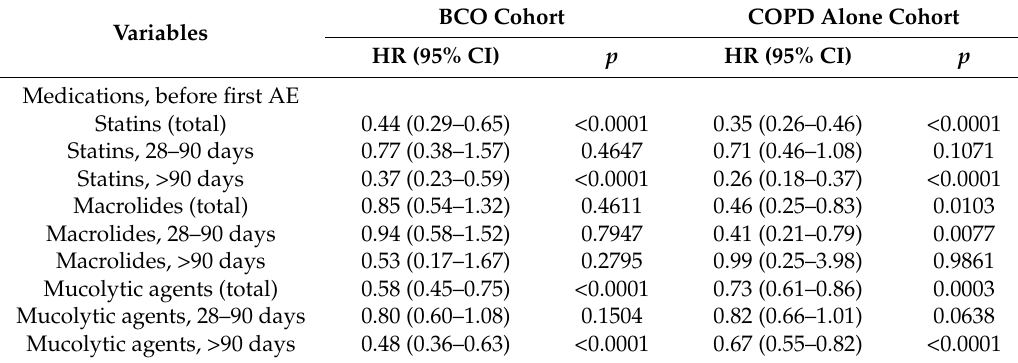
Table 3. Sensitivity analysis for the effects of medications on acute exacerbations in the bronchiectasis- COPD overlap (BCO) and chronic obstructive pulmonary disease (COPD) alone cohorts. BCO Variables